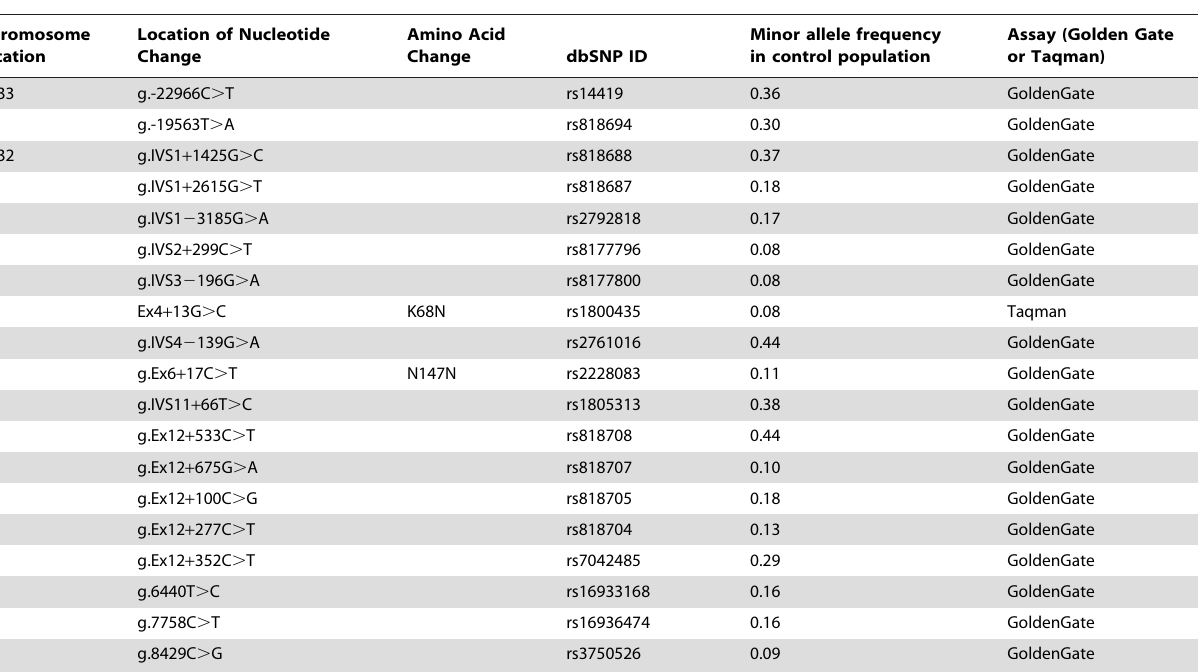
Table 1. ALAD tagging Single Nucleotide Polymorphisms (SNPs) evaluated in the Central Eastern European Renal Cancer Study.